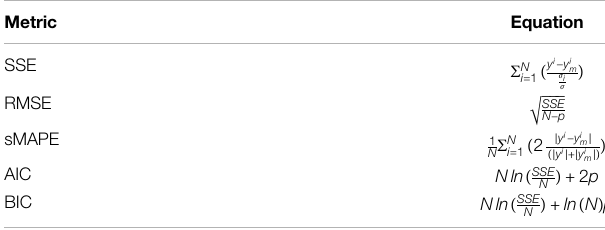
TABLE 2 | Evaluation metrics for data-driven relation learning systems. We consider N — number of measurements, σ — standard deviation of data, p — number of parameters of the